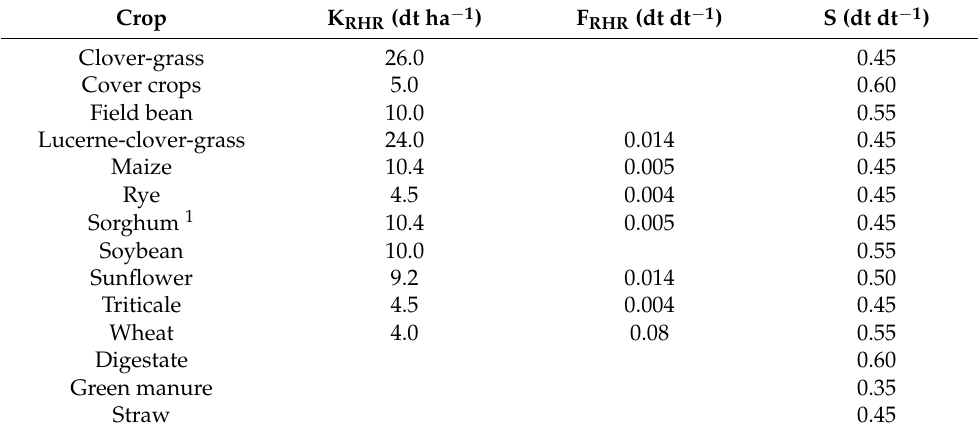
Table 4. Crop-specific C input parameters K RHR , F RHR and synthesis coefficient S used to calculate C RHR and C input to soil organic carbon (SOC), adapted from the CANDY model [34].